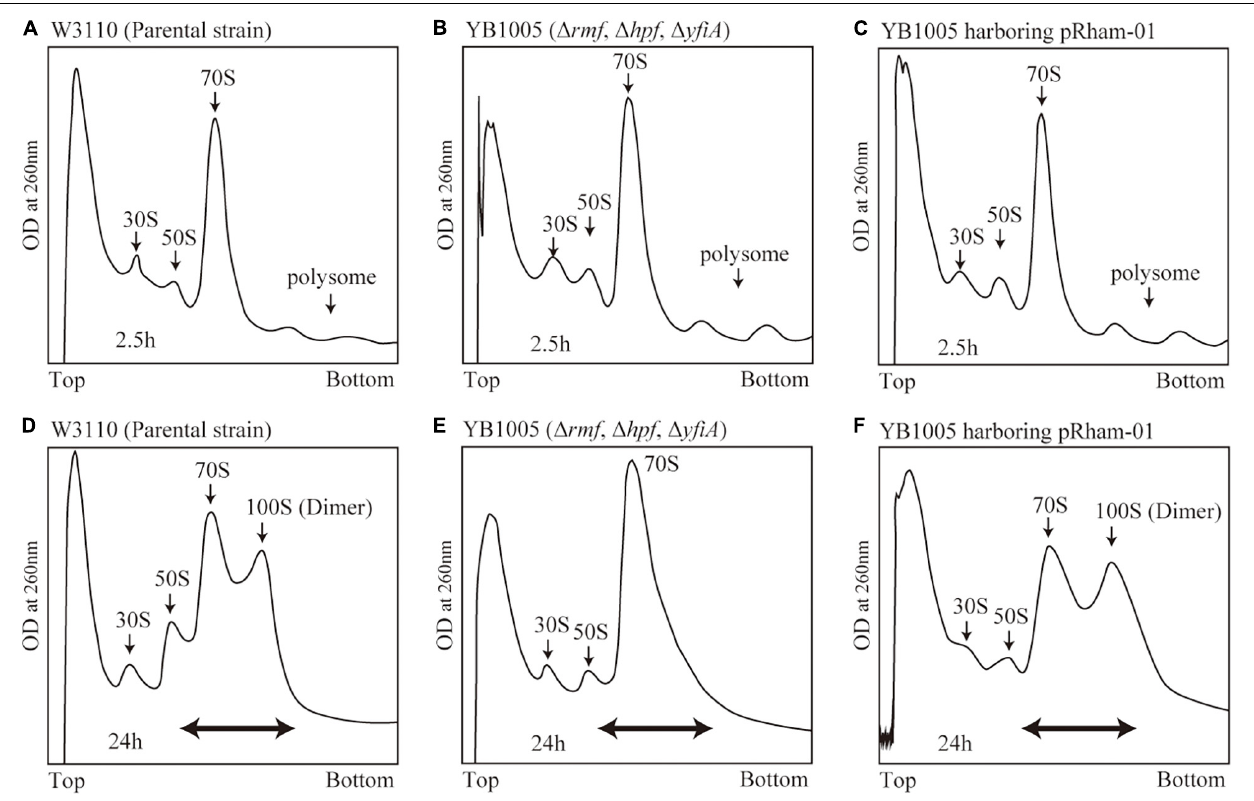
FIGURE 2 | Formation of 100S ribosome after the expression of intact rmf and hpf genes from the pRham plasmid. (A–C) Profiles of ribosomes extracted from the cells during the exponential phase (harvested 2.5 h after inoculation) after sucrose density gradient centrifugation. (D–F) Ribosome profiles during the stationary phase (at 24 h). (A,D) Represent the W3110 strain (wild-type); (B,E) Represent the YB1005 strain (obtained from W3110 by the deletion of rmf , hpf, and yfiA genes); (C,F) Represent the YB1005 strain harboring the pRham-01 plasmid (carrying intact rmf and hpf genes, as shown in Table 1 ). The double-headed arrows in (D–F) indicate the fractionated regions that were analyzed by western blot (see Figure 5